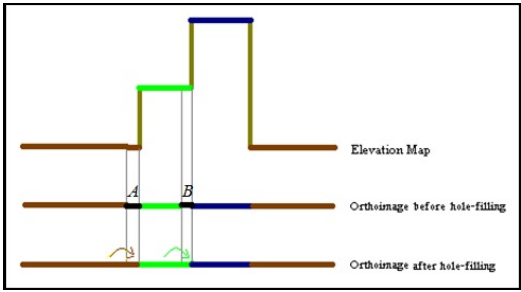
Figure 6. Hole-filling preserving